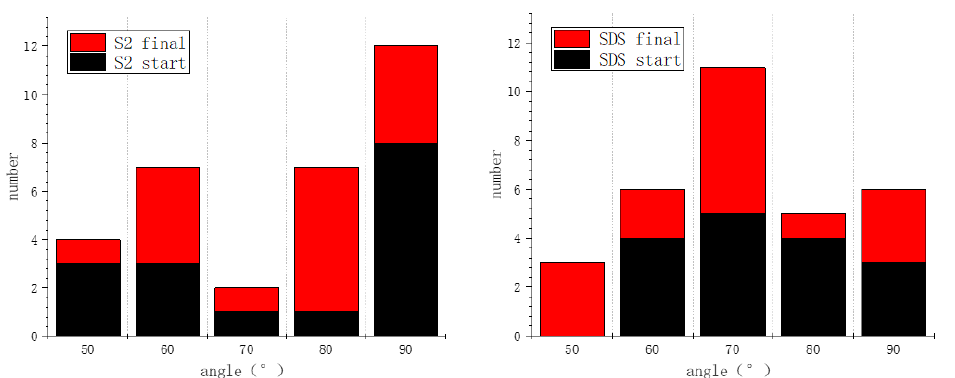
Figure 6. The distribution of the angle between the surfactant molecular chain and the Z axis before and after MD simulation.